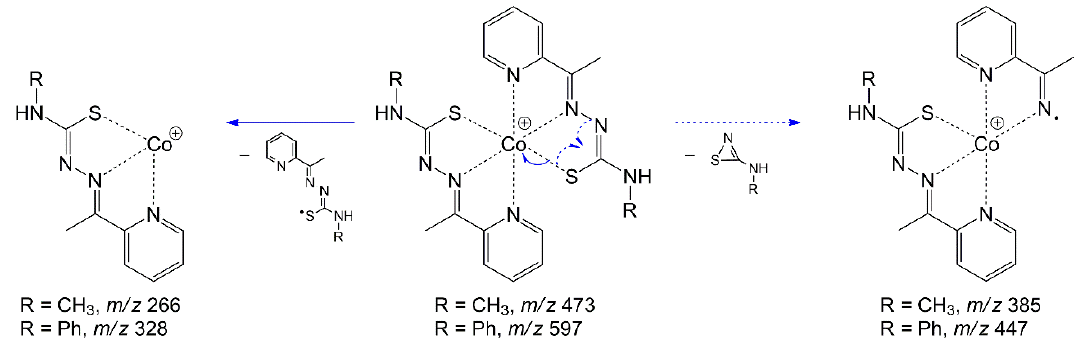
Figure 2. Fragmentation pathway proposed for 1 ( m/z 473) and 2 ( m/z 597) analyzed by (+)-ESI – MS/MS.